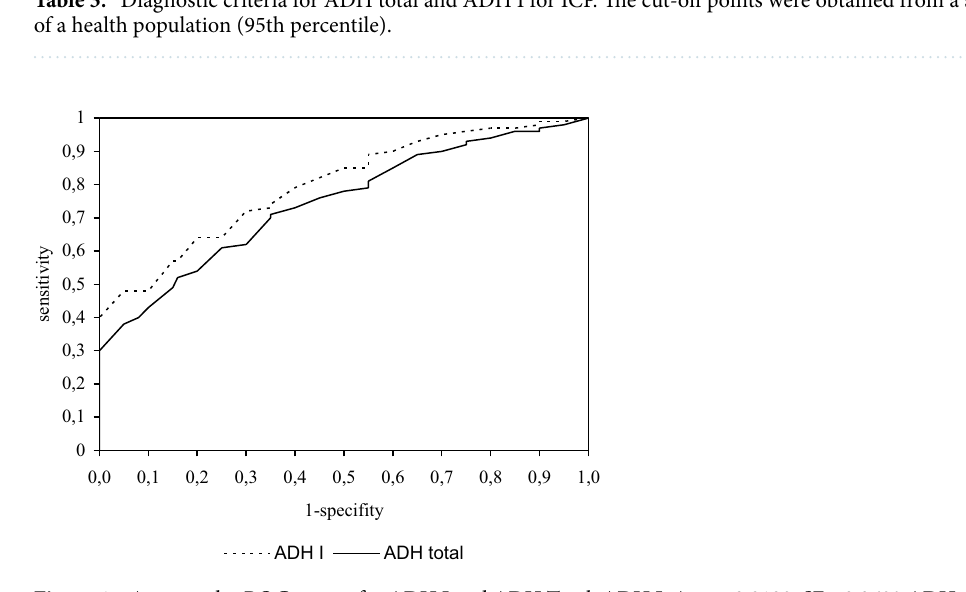
Figure 1. Areas under ROC curves for ADH I and ADH Total. ADH I, Area = 0.8103, SE = 0.0639.ADH total, Area = 0.7735, SE =